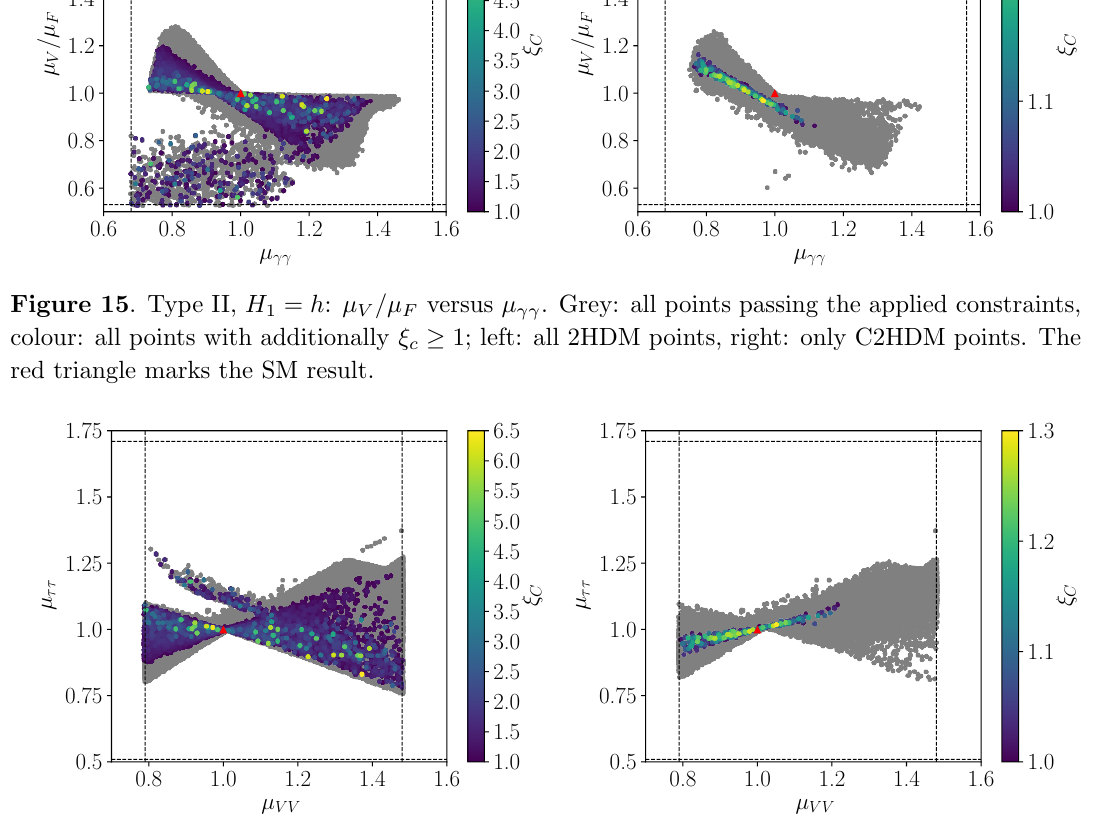
Figure 16 . Type II, H 1 = h : (cid:22) V =(cid:22) F versus (cid:22) (cid:13)(cid:13) . Grey: all points passing the applied constraints, colour: all points with additionally (cid:24) c 1; left: all 2HDM points, right: only C2HDM points. The (cid:21) red triangle marks the SM